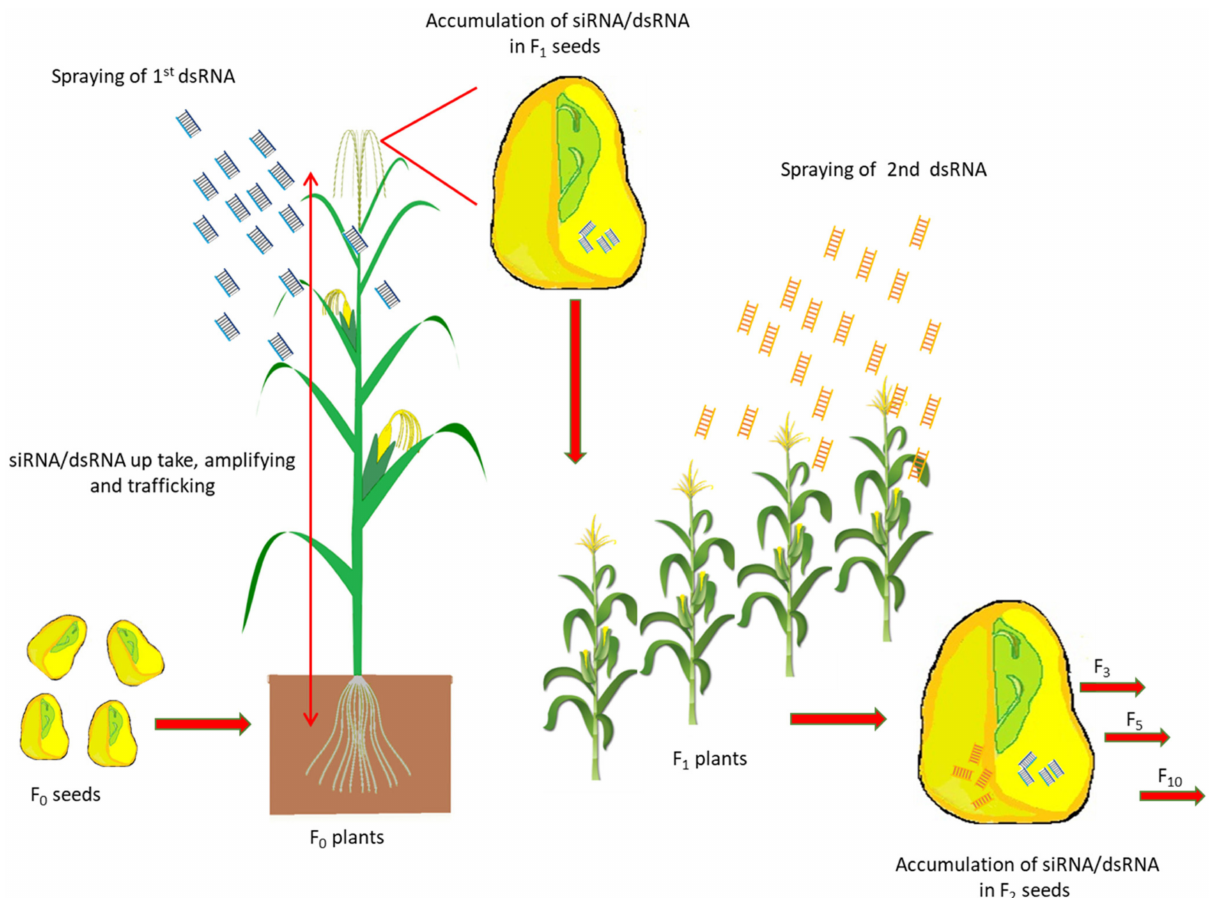
Figure 3. Predictable model illustrating effect of dsRNA spraying on seed genomic modifications. After foliar application of dsRNA, plants accumulate the Ex-dsRNA, and the dsRNA/siRNA signals in plants can spread systemically through the vascular tissue system. Accumulation of siRNA due to different applicable dsRNAs may lead to phenotypic variation in plants from generation to other generations. The expansion of siRNA could produce preferable mutations or modify the gene’s functions as the epigenetic modifications in plants can be directed and mediated by